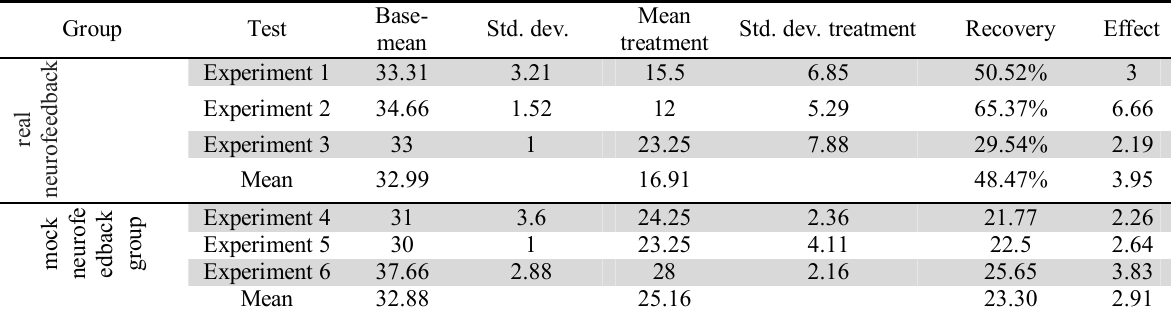
The results of BDI-II for two groups Group